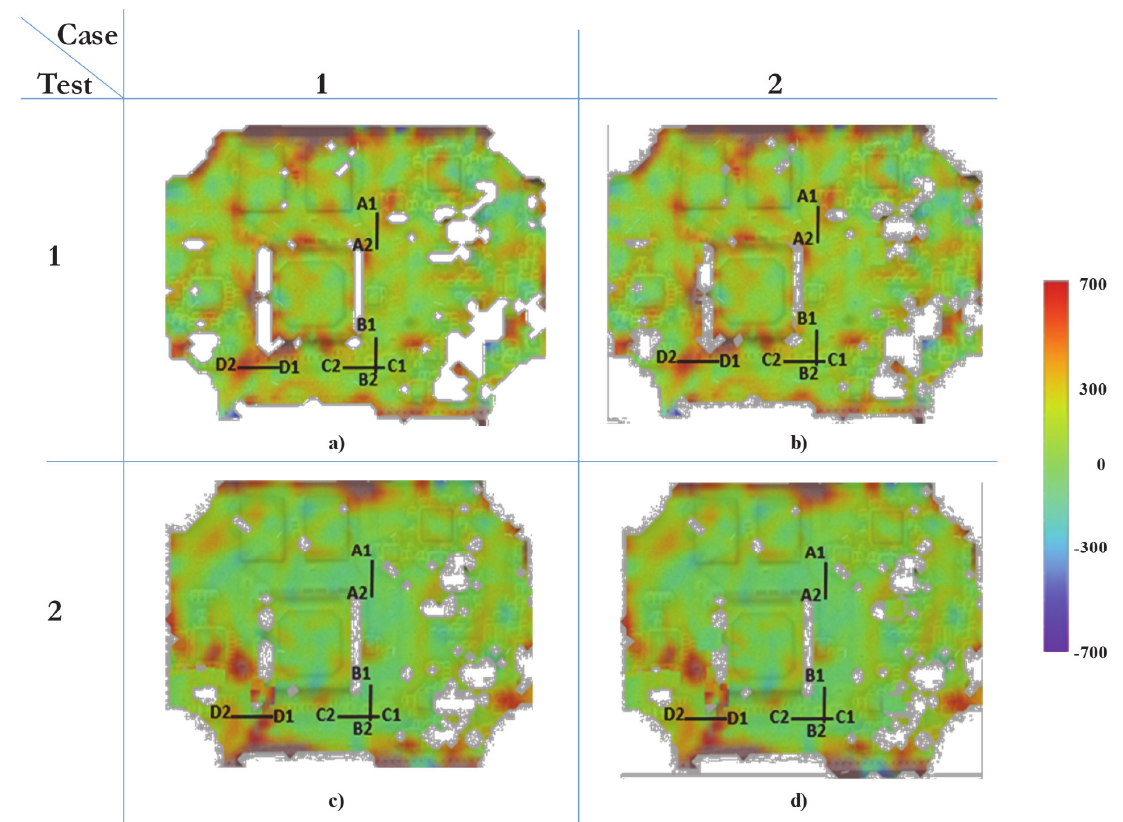
Figure 10: DIC maximum principal strains distribution on PCB: a) Loading case 1 Test 1; b) Loading case 1 Test 2; c) Loading case 2 Test 1; d) Loading case 2 Test